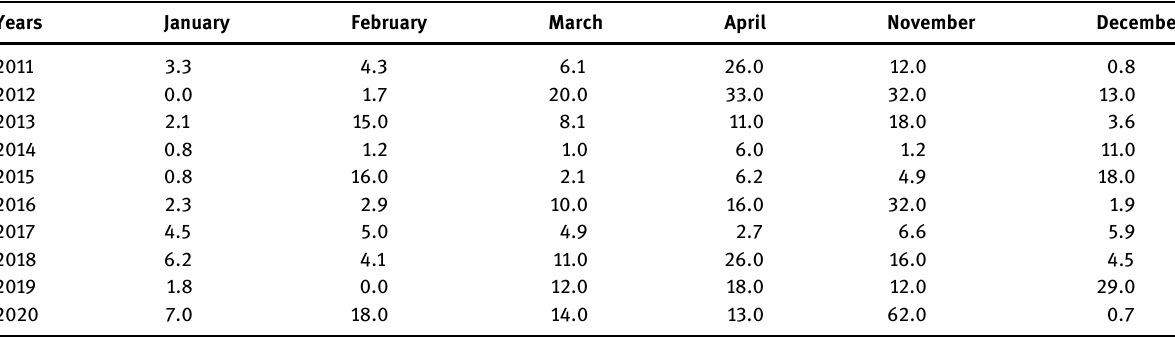
Table 2: Total monthly precipitation ( mm ) in Harbin from 2011 to 2020